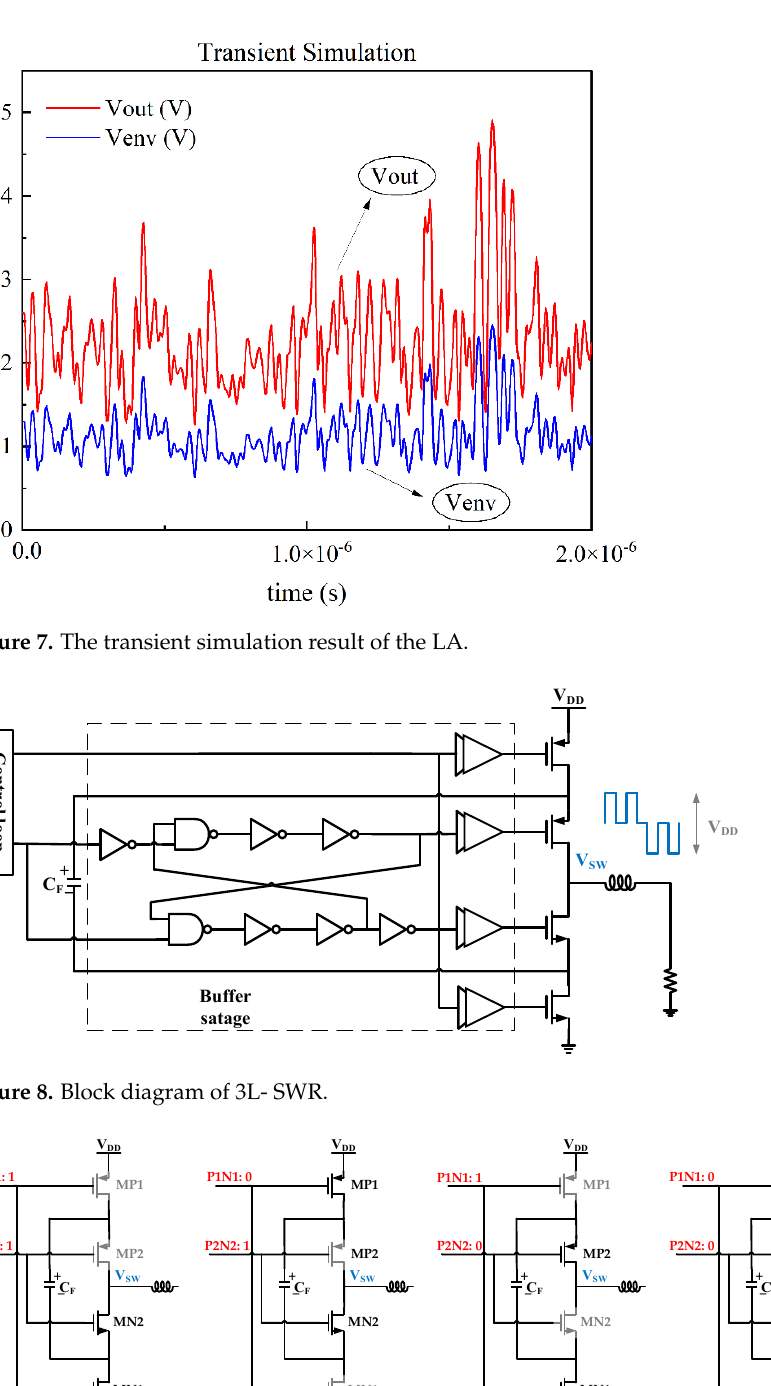
Figure 8. Block diagram of 3L- SWR.